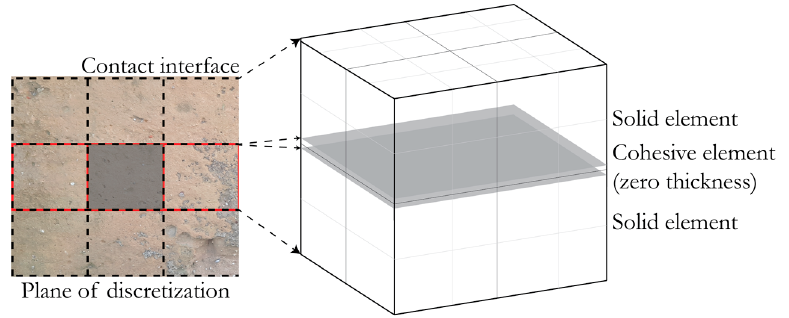
Figure 9. Procedure utilizing the automated algorithms in LS-DYNA for pre-processing, processing, and post-processing of the building models.